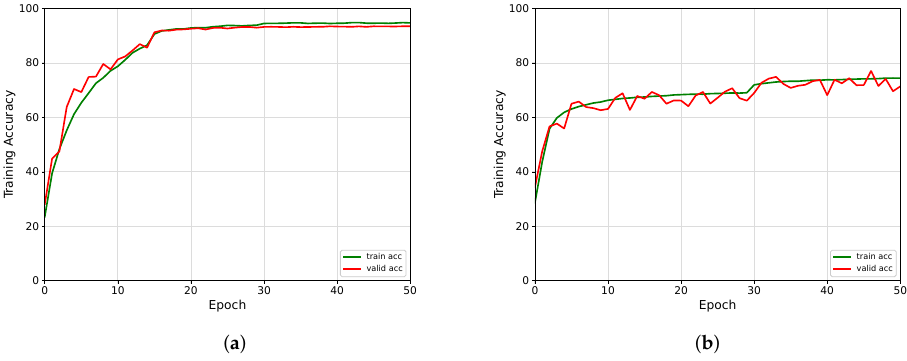
Figure 5. Change in training accuracy in pre-training stage, ( a ) shows training accuracy on base data, and ( b ) shows training accuracy on self-supervised data.